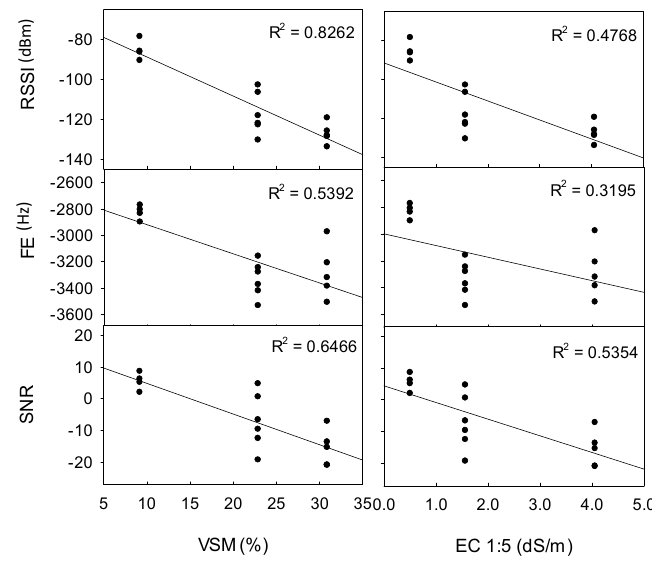
Figure 5. Effect of soil moisture (VSM) and salinity (EC 1:5) on signal quality at Site 1b (Rudosol) at transmission distances of 10 m, 20 m, and 30 m (TX power +15 dBm and +23 dBm, 0.2 kbps data rate, 1/14 λ TX antenna, 1/3 λ RX antenna). RSSI (dBm) refers to received signal strength index, FE (Hz) refers to frequency error, and SNR refers to signal-to-noise ratio. Error bars indicate ±1 standard deviation.